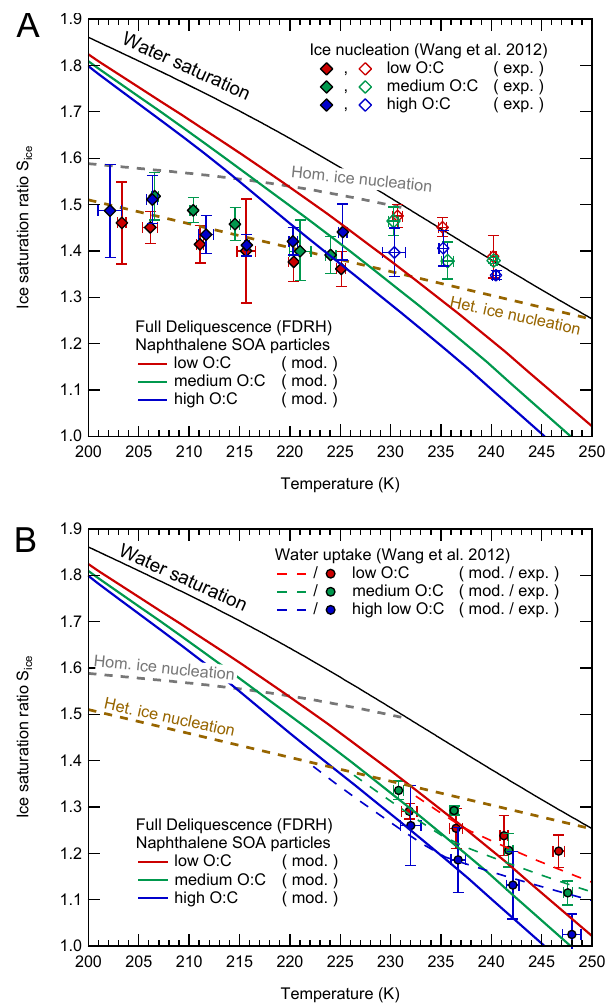
Figure B1. Comparison between calculation results of naphthalene SOA deliquescence and experimental ice nucleation and water up- take data from Wang et al. (2012). For the numerical simulations, aerosol particles are assumed to be 1µm in diameter and are humid- ified at a rate of 1% RH min − 1 , corresponding to a cooling rate of about 0.1Kmin − 1 as used by Wang et al. (2012).